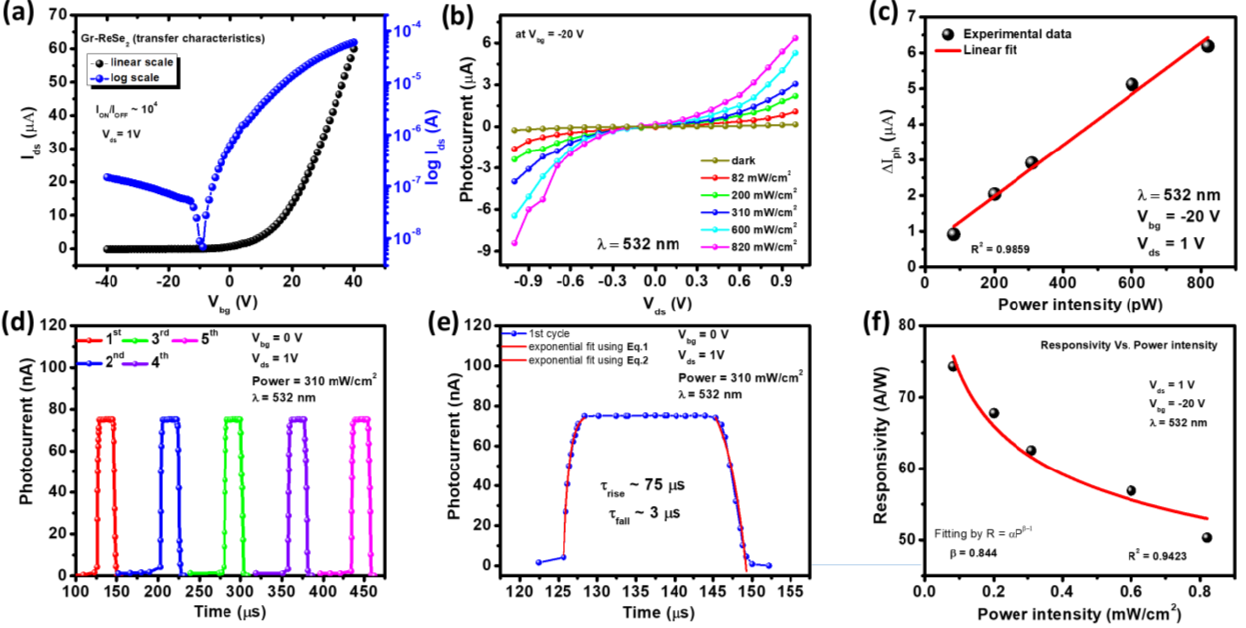
Figure 3. Graphene/ReSe 2 heterostructure characteristics: ( a ) transfer characteristics (I ds –V bg ) both in linear (black curve) and log-scale (blue curve) measured at V ds = 1 V showing on/off ratio of ~10 4 . ( b ) Output characteristics (I ds –V ds ) in dark and under various light intensities (82–820 mW/cm 2 ) conditions measured at V bg = −20 V and incident light wavelength of 532 nm. ( c ) Observation of linear relationship between ΔI ph = I ph – I dark and light power intensities evaluated at V bg = −20 V, V ds = 1 V, and λ = 532 nm (where R 2 = 0.9859). ( d ) Measurement of photocurrent for five consecutive cycles without any biasing at V ds = 1V, power = 310 mW/cm 2 , and λ = 532 nm. ( e ) Corresponding measurement of photoresponse (rise time (75 µs) and fall time (3 µs)) of the graphene/ReSe 2 heterostructure-based photodetector. ( f ) Responsivity versus power intensity trend follows relationship R = αP β−1 with calculated β = 0.844.